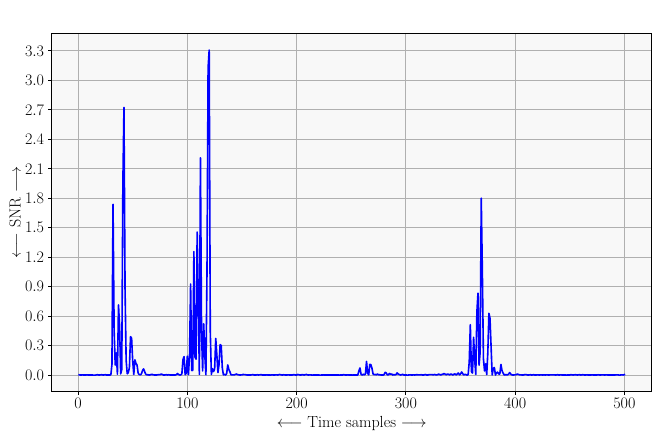
Figure 2: SNR for the measurement